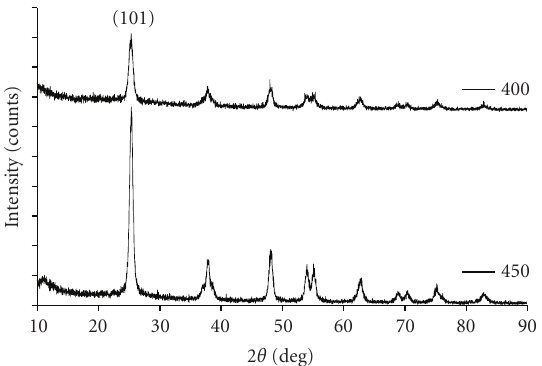
Figure 2: Wide-angle XRD patterns of nanoporous TiO 2 .